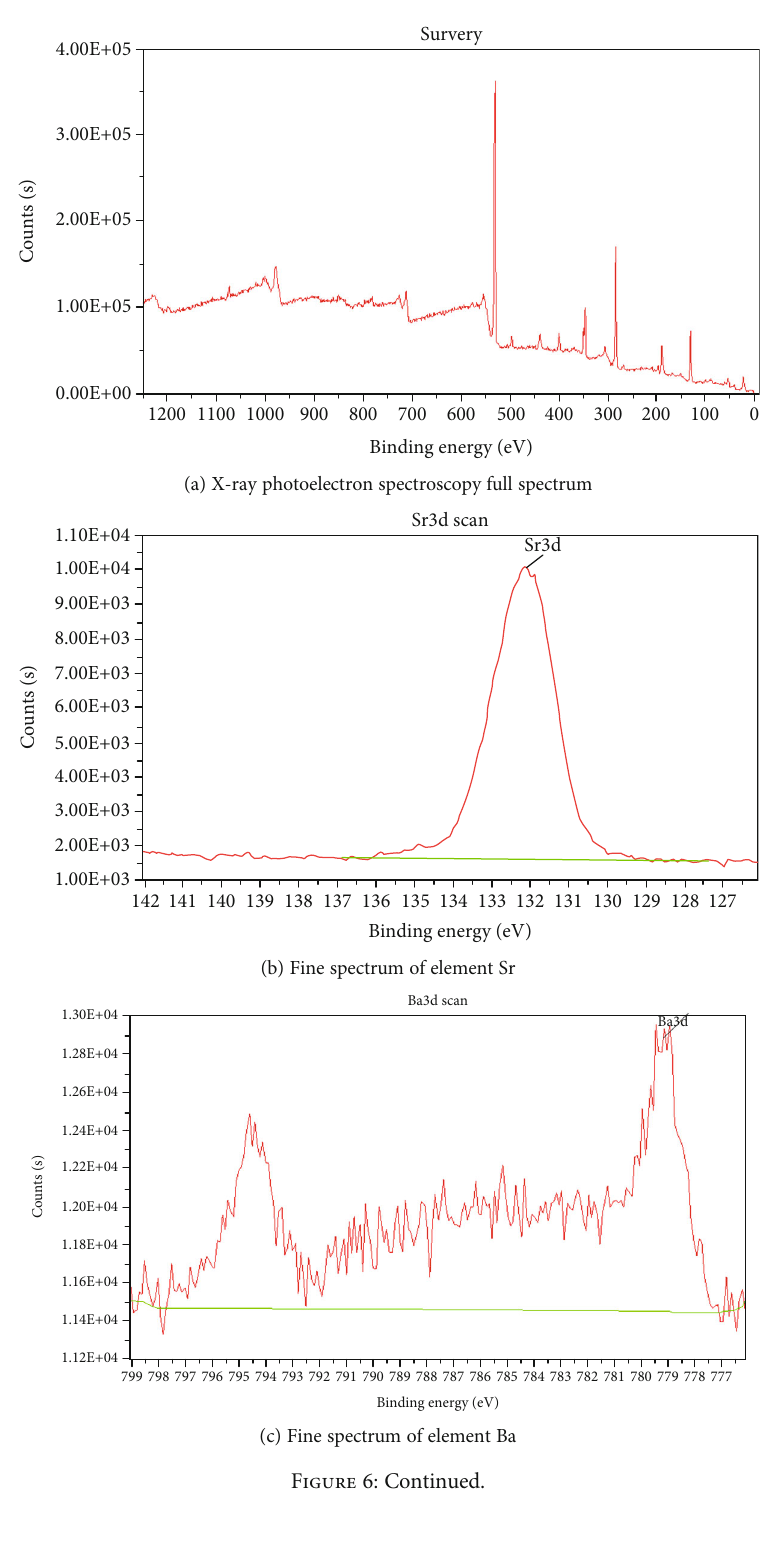
(c) Fine spectrum of element